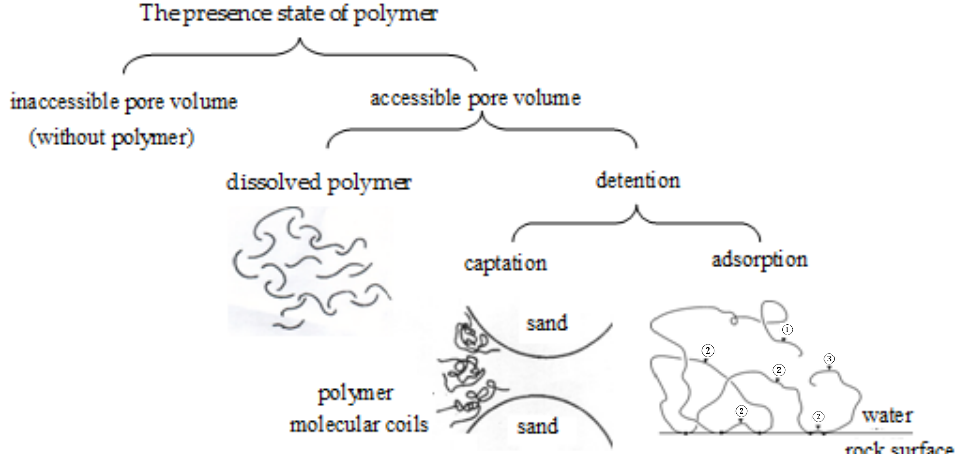
Figure 1. The present state of the polymer in strata. Table 1. Effect of the inaccessible pore volume (VIP) on polymer flooding development index